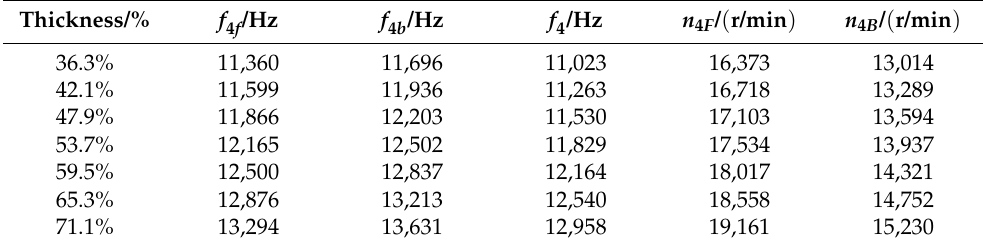
Table 10. The change of the 4th ND TWR speed at different thickness of spoke